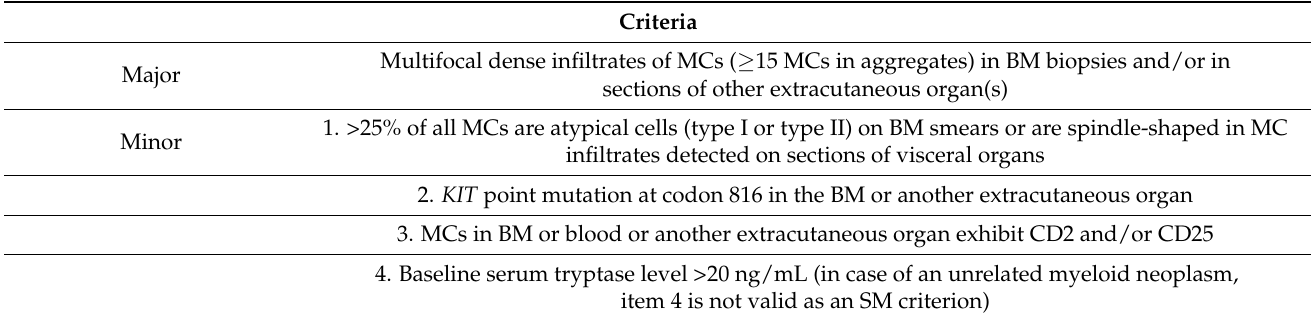
Table 3. Major and minor criteria for the fulfillment of SM diagnosis (according to Valent P et al. [22]). Criteria